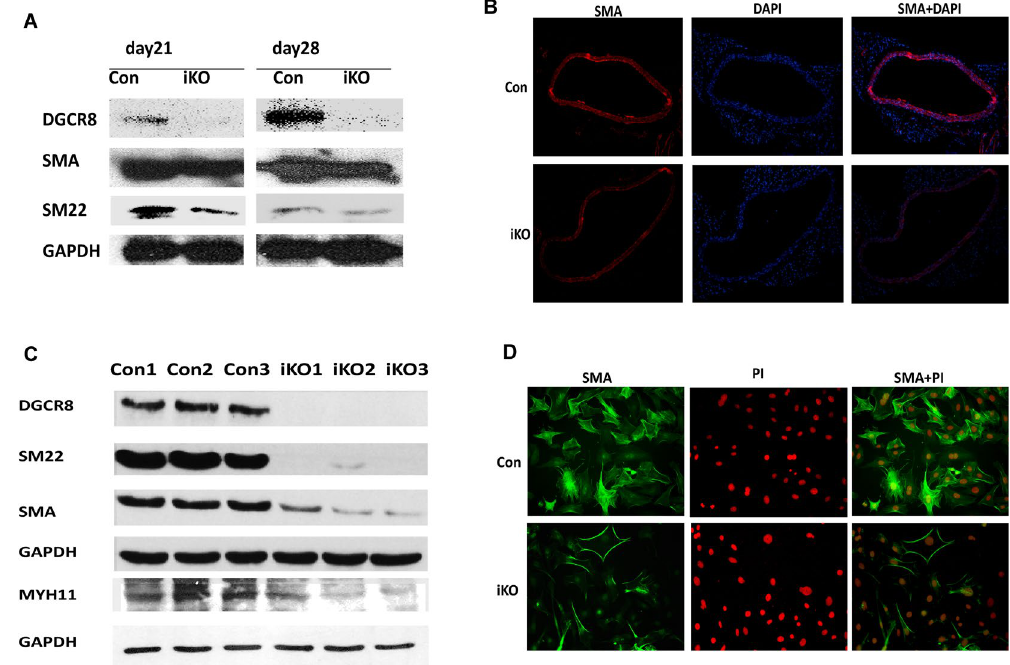
Figure 4. DGCR8iKO mice display reduced VSMC differentiation marker gene expression. ( A ) SMA and SM22 were detected from DGCR8iKO and control mice on day 21 and day 28 following tamoxifen injection by Western blot (full blot shown in Figure S1). ( B ) Sections of thoracic aorta of DGCR8iKO and control mice on day 28 following tamoxifen injection were detected by SMA immunostaining. SMA was stained with red immunofluorescence and nuclei were stained blue with DAPI. ( C ) VSMC marker gene expression in primary VSMCs isolated from three different DGCR8iKO and control mice was detected by Western blot (full blot shown in Fig. S2A,B and C). ( D ) SMA expression in primary VSMCs of DGCR8iKO and control mice was immunostained with SMA antibody. Cell nuclei were stained by